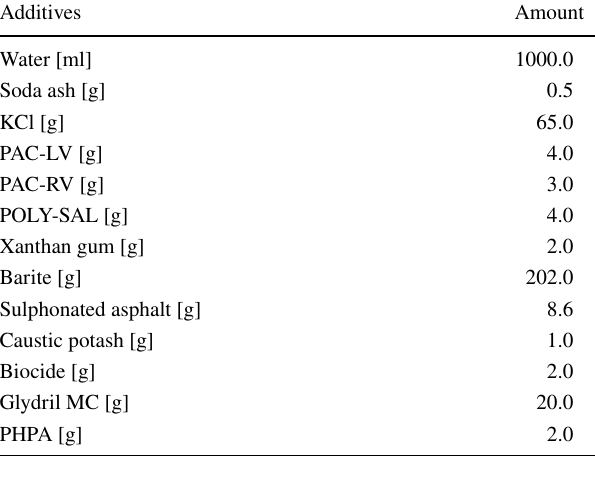
Table 2 KCl–Glycol–PHPA polymer-WBM formulation